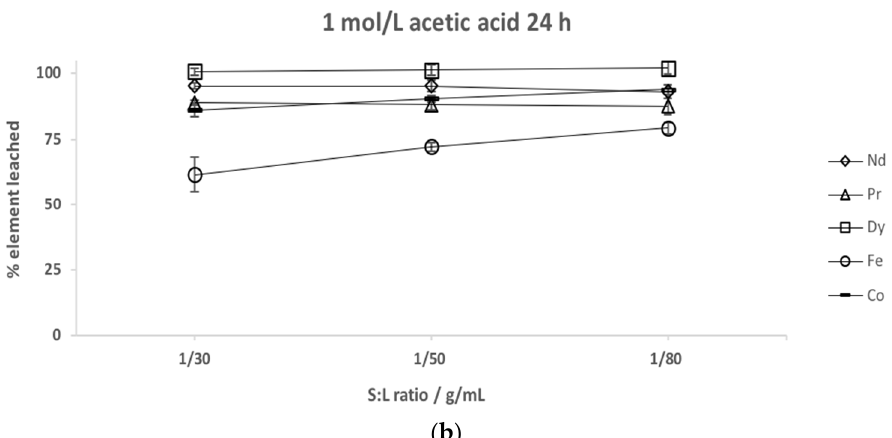
Figure 5. The dependence of the amount of Nd leached on the S:L ratio at 25 ± 1 °C using ( a ) 1 mol/L citric acid and ( b ) 1 mol/L acetic acid with 400 rpm stirring for 24 h in both cases.